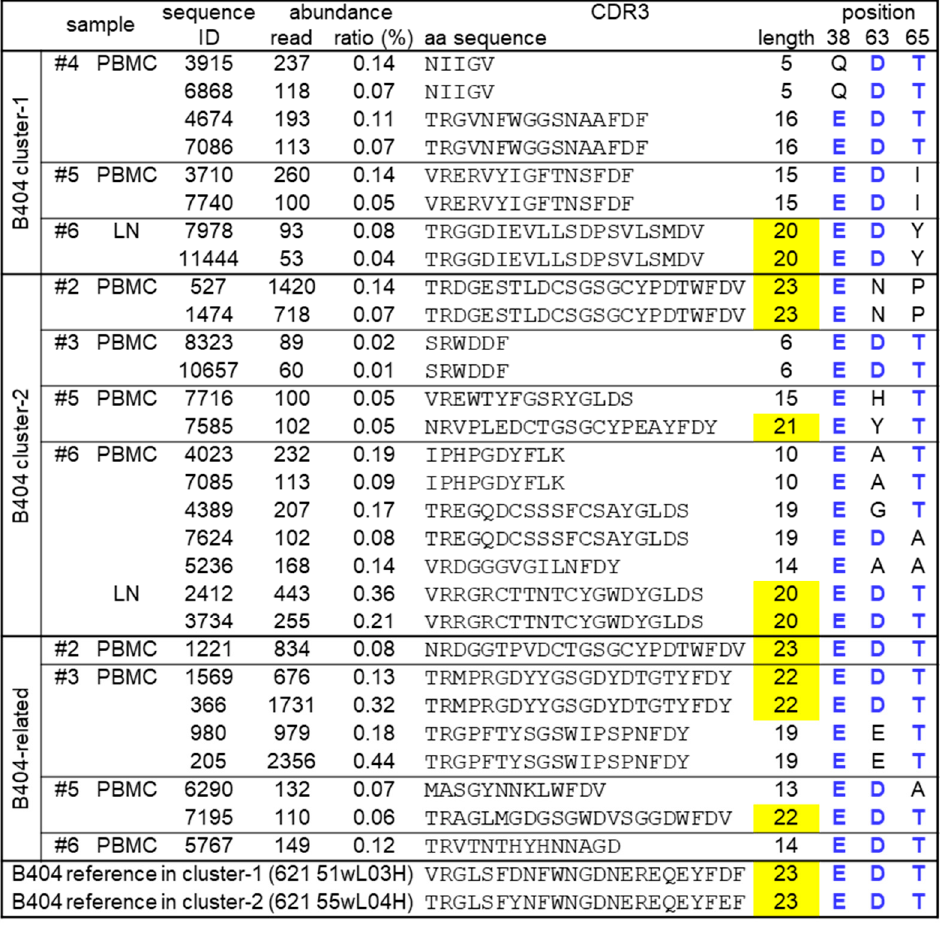
Figure 4. VH sequences clustered with B404-class antibodies. VH sequences more than fifty reads, which were included in B404-class cluster-1, cluster-2, or B404-related, are shown. B404-class VH controls obtained in our previous study are also shown at the bottom [16]. In individual sequences, derived samples, abundance, CDR3 amino acid (aa) sequences and lengths, and the residues 38, 63, and 65 in VH3.33 are shown. The CDR3 lengths with 20 aa or longer are highlighted in yellow. Blue letters mean amino acids which are identical to those in B404-class Abs in our previous study [16].